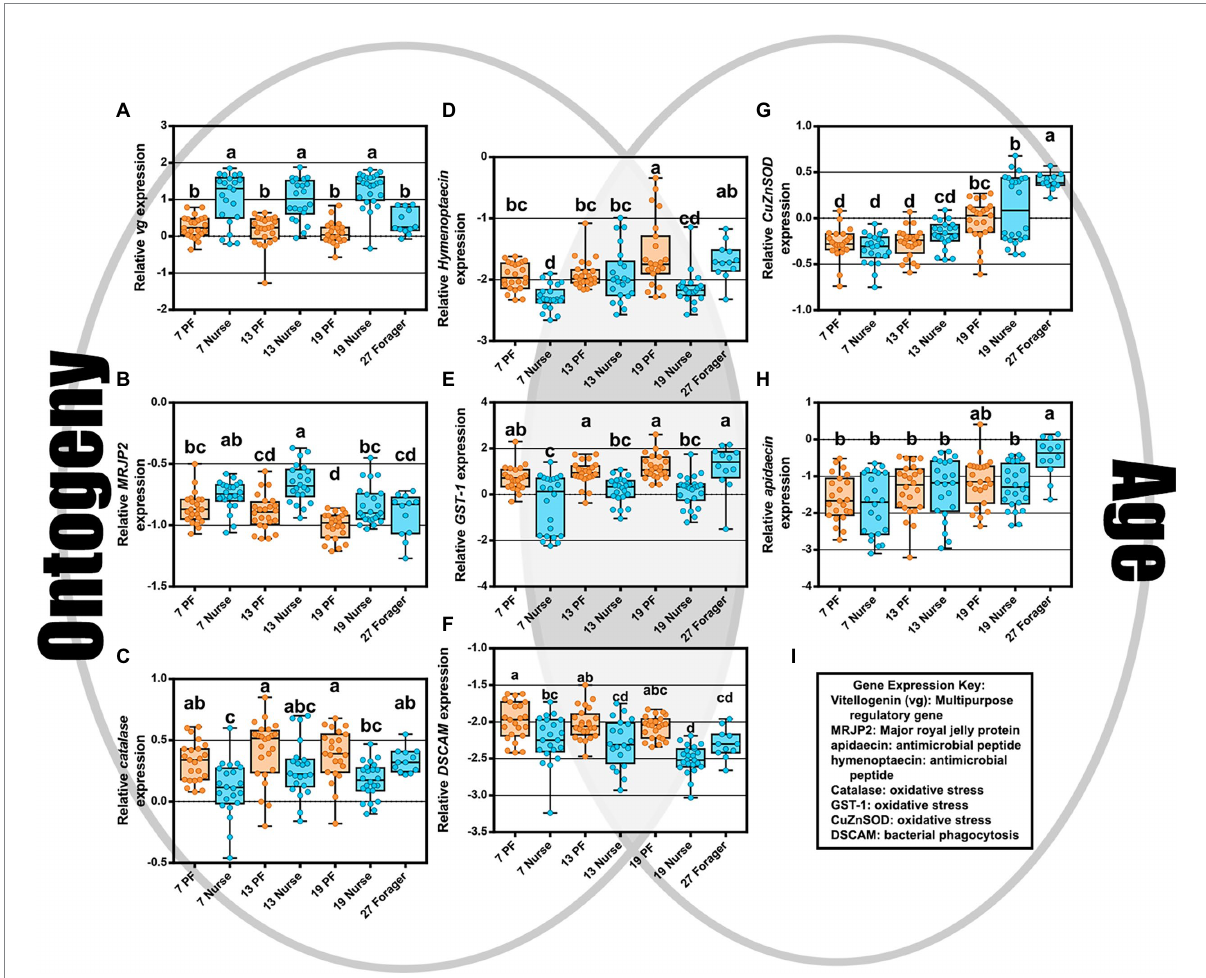
FIGURE 4 As depicted by the Venn diagram (gray background), gene expression reflects ontogeny, age, or an interaction of the two. (A–C) Vitellogenin, MRJP2, and catalase expression were associated with ontogeny. (D–F) hymenoptaecin, GST-1, and DSCAM expression were explained by either an interaction factor or combination of both ontogeny and age. (G,H) CuZnSOD and apidaecin expression increased with age regardless of ontogeny. (I) Key explaining functional roles of gene expression. Different letters indicate significant differences ( p < 0.05).